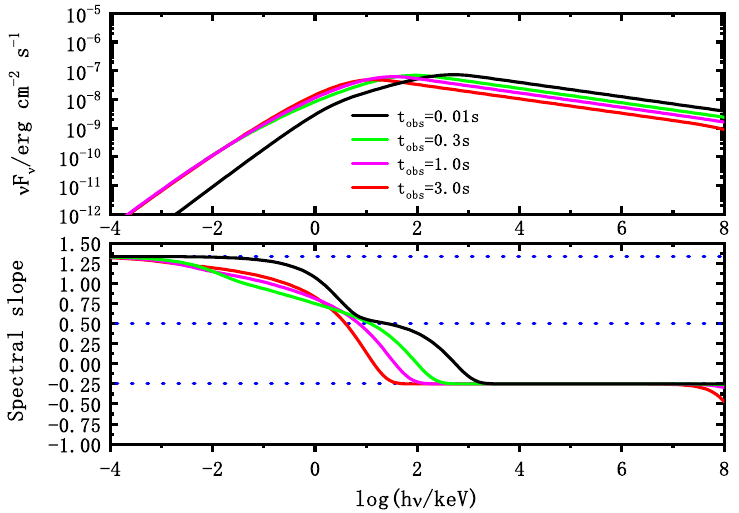
Figure 3. The top panel corresponds to time-resolved spectra in four different t as in Figure 2 and the bottom panel shows corresponding synchrotron spectral slopes. The same δ t , t crs , and dynamics parameters as in Figure 1 are taken in numerical